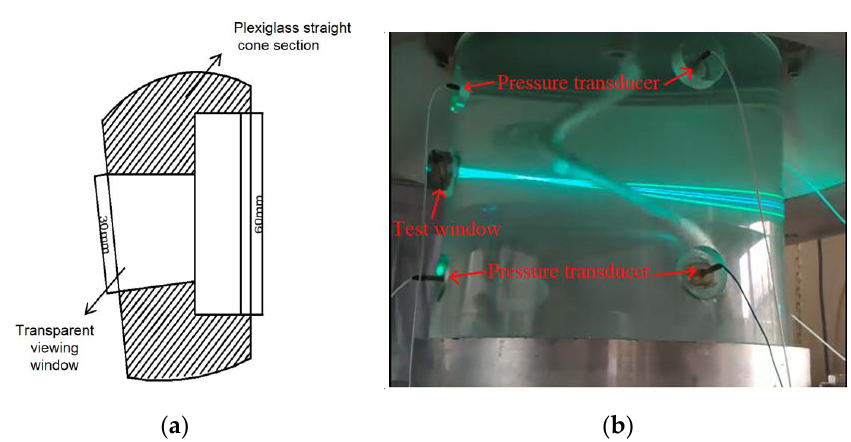
Figure 2. Test point distribution along the test radius.